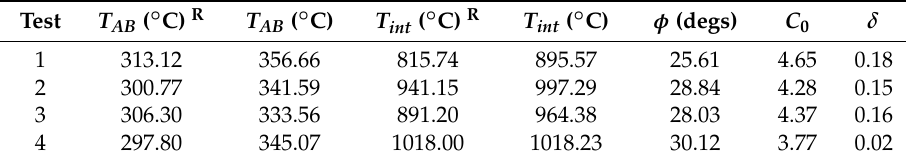
Table 3. Predicted temperatures and other process variables in orthogonal machining of AISI 1045 steel.